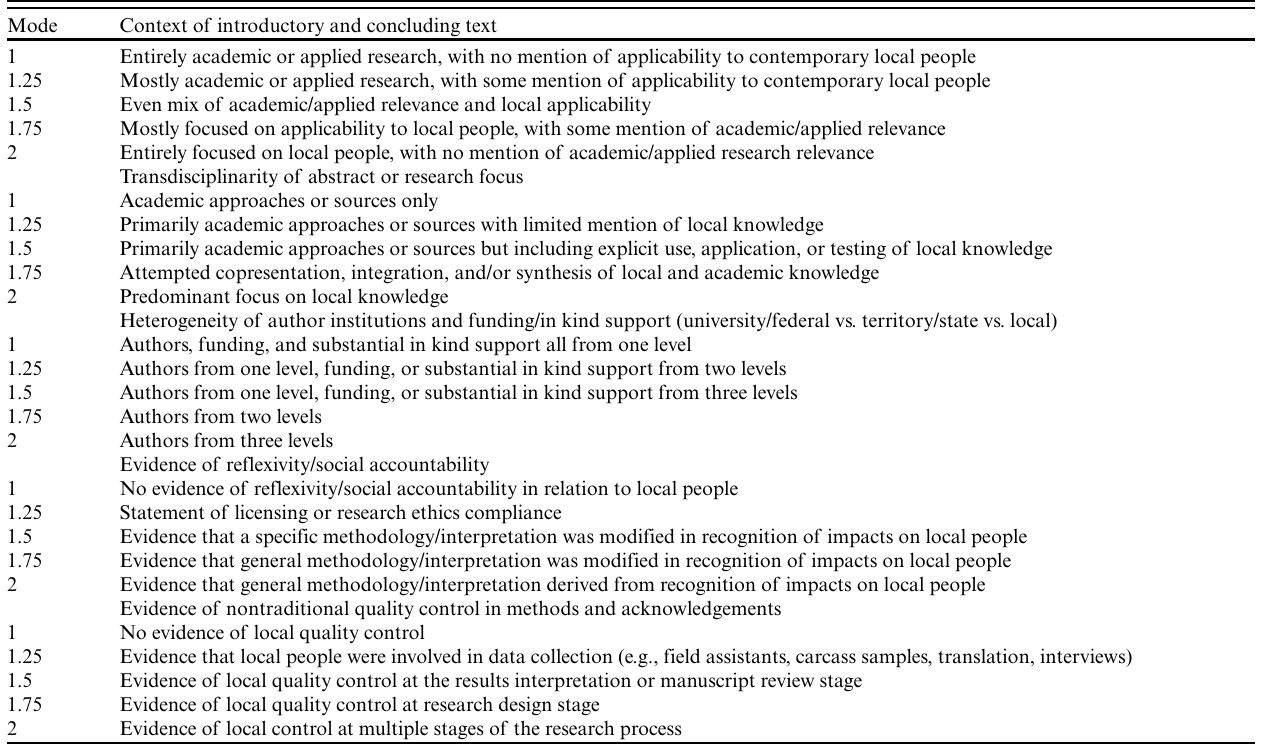
Table 2 . Criteria used to evaluate the Mode of knowledge production in Arctic